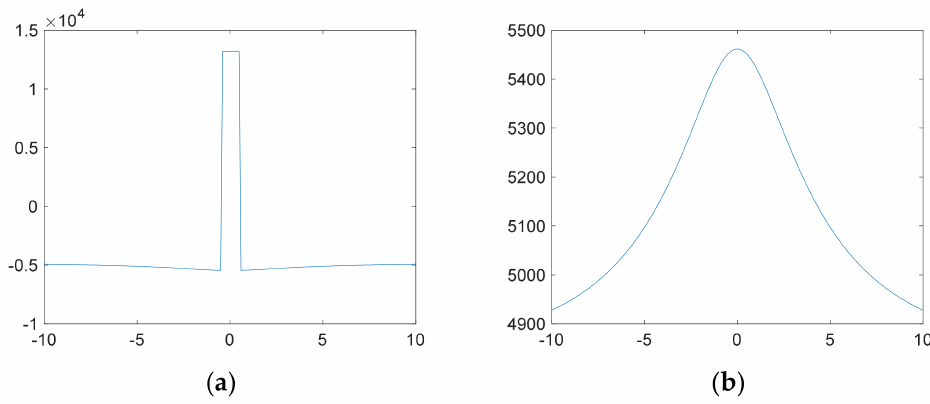
Figure A3. ( a ) Pressure profile along 5 + 5i and 5 − 5i in Figure A1. Horizontal scale shows distance in meter and vertical scale is pressure in Pa. ( b ) Pressure profile along − 5 + 5i and − 5 − 5i in Figure A1. Horizontal scale shows distance in meter and vertical scale is pressure in